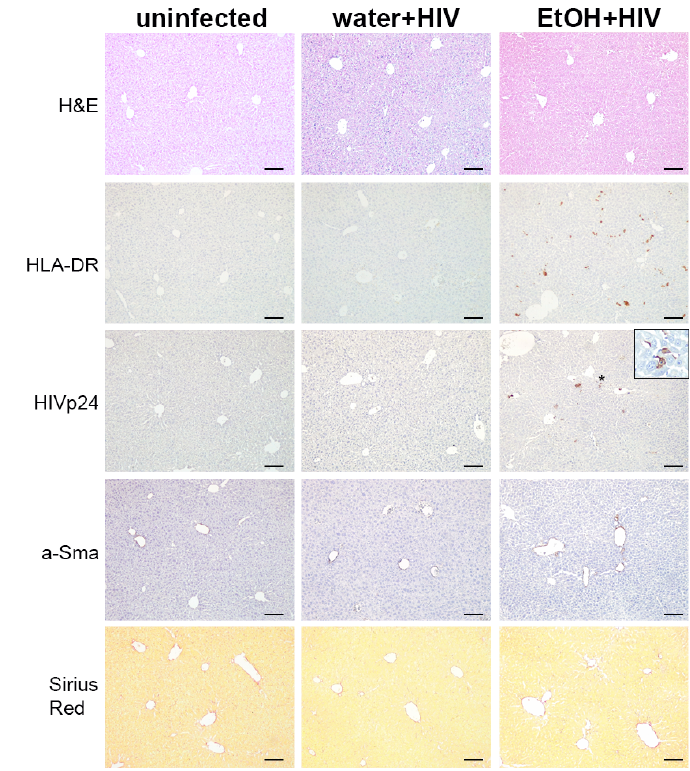
Figure 8. Liver pathomorphology in HIV-1 infected animals consuming alcohol in water. Humanized mice were fed 20% w / v alcohol in drinking water and infected with HIV-1 for 5 weeks. Liver tissues of uninfected and HIV-1-infected water- or alcohol-drinking mice were fixed, paraffin-embedded, and 5 μm sections were stained for H&E, human HLA-DR, HIVp24, a-SMA, and Sirius Red, as indicated. Human cells positive for HLA-DR and HIVp24 staining were observed in the parenchyma, and some infected cells (star) were apoptotic, as shown in a magnified view (inset) of the boxed area. There were no differences in stellate cell activation or collagen deposition. Scale bars: 100 μm. Each mouse group had 4 mice.